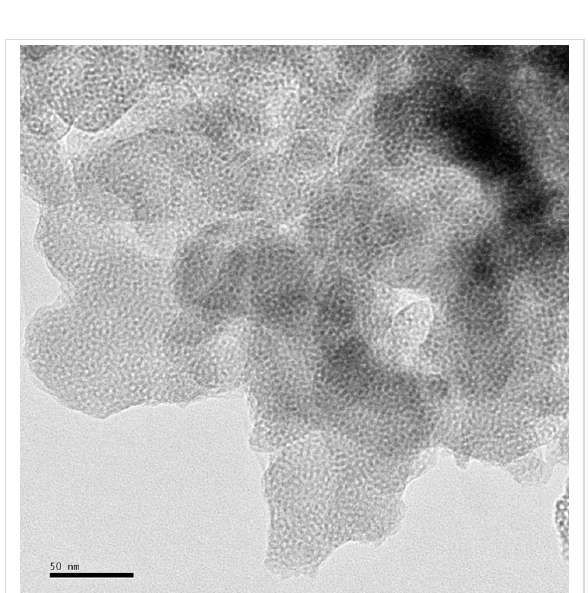
Figure 3: The HRTEM images of V-Ti/MCM-41 photocatalyst.